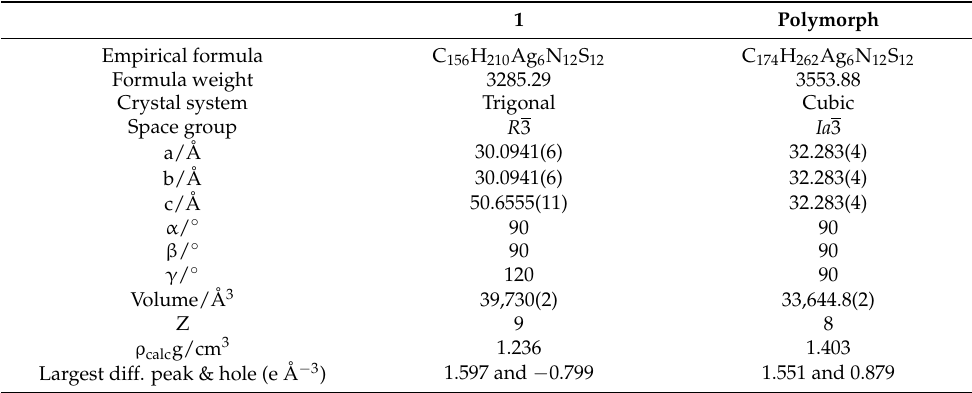
Table 2. Comparison of some selected X-ray crystal data collection and structure refinement parame- ters for complex 1 and its polymorph.